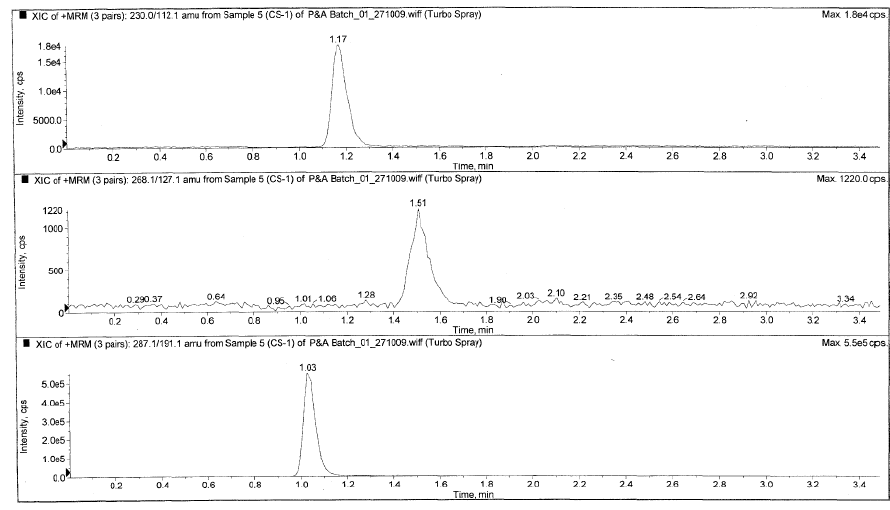
Figure 1. Spectrum for Lamivudine, Zidovudine, and Abacavir.